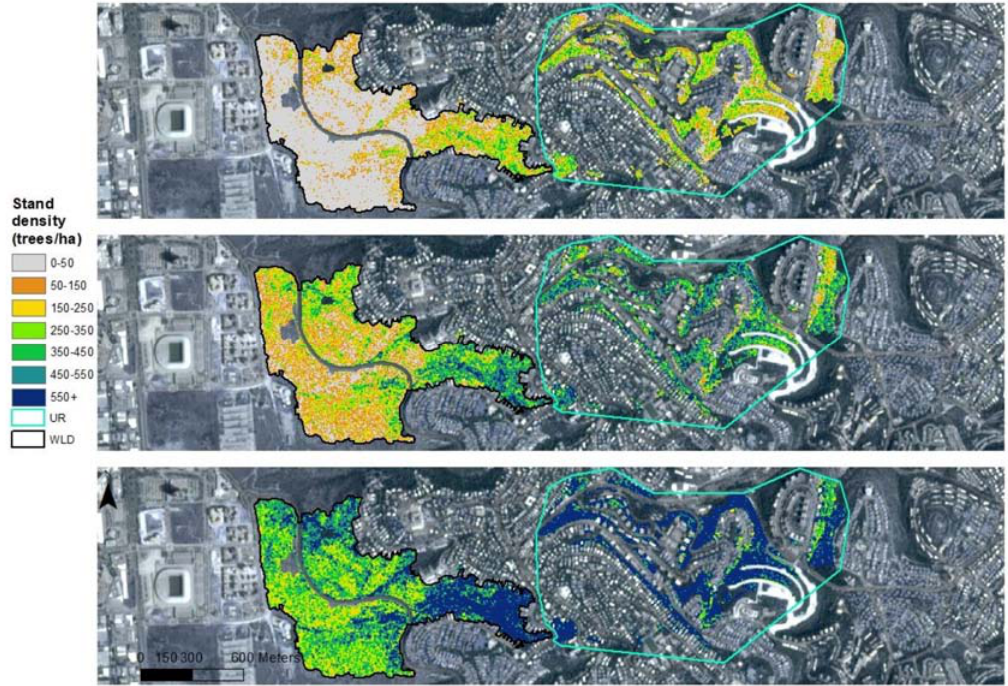
Figure A3. Maps of low-to-high estimates of stand density (trees ha − 1 ) in the WUI derived from Planet: using the calibration equation minus the MAE (upper map); using only the calibration equation (middle map); and using the calibration equation plus the MAE (bottom map).